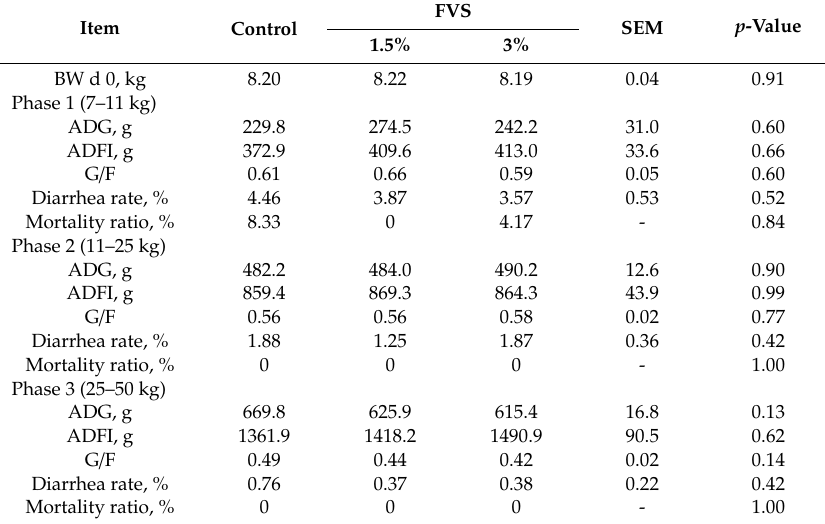
Table 7. E ff ects of Flammulina velutipes stem waste (FVS) supplementation in diets fed to weaned piglets on growth performance during day 1–56